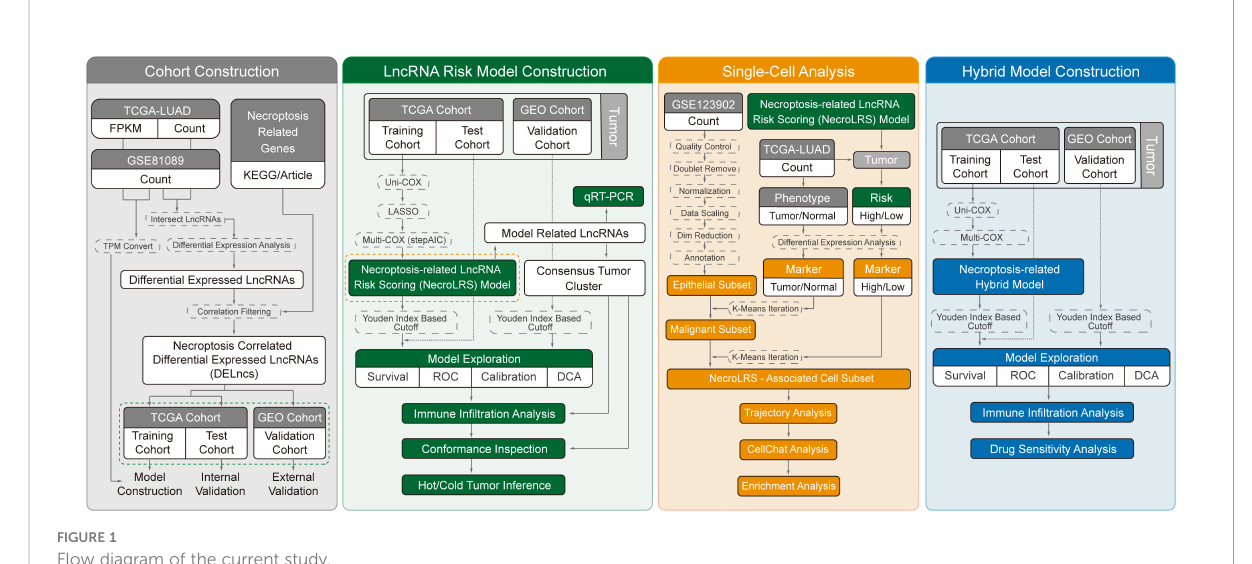
FIGURE 1 Flow diagram of the current